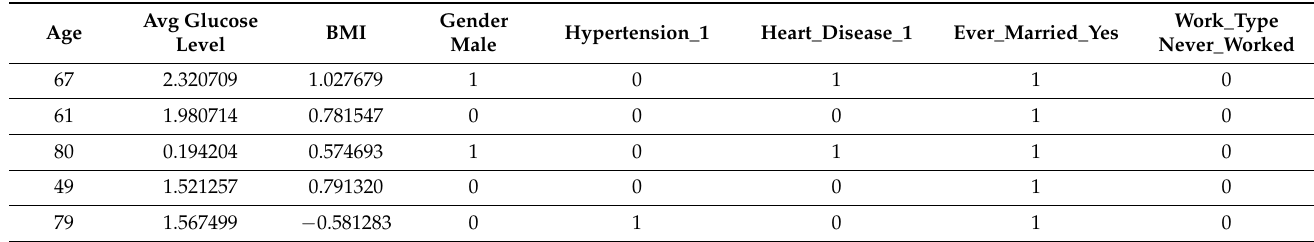
Table 3. The stroke prediction dataset after applying the